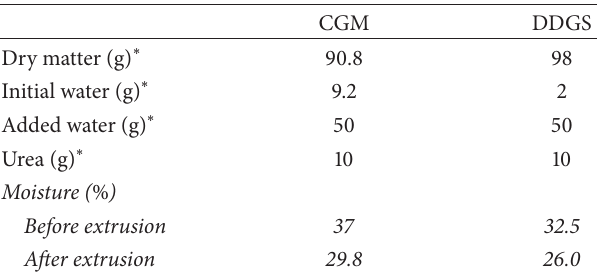
Table 3: Moisture content of CGM and DDGS before and after extrusion, based on adding water and urea in the amounts shown per 100 g CGM or